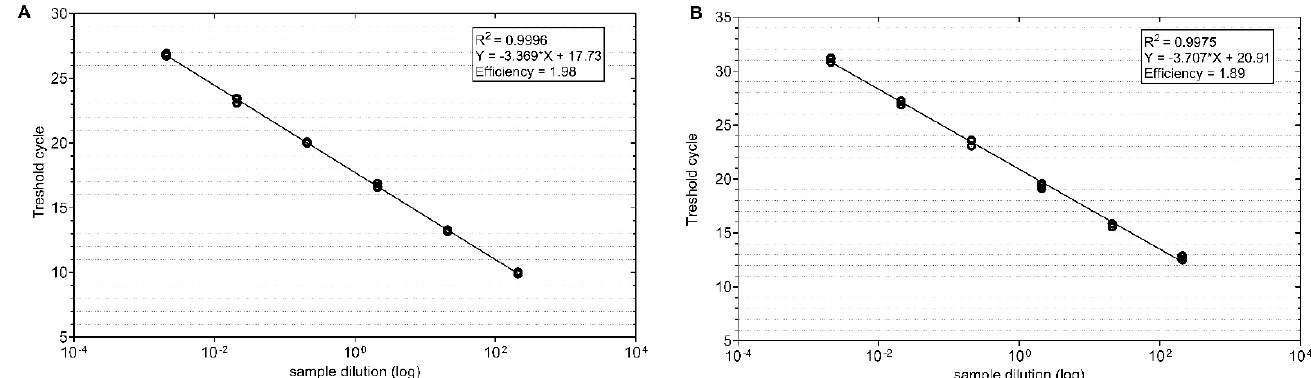
Figure 3. Standard curves for SYBR Green-I-based real-time RT-PCR amplification of standard TuYV DNA with specific primer sets ( A ) TuYV K1 and ( B ) TuYV K2. The amplification plots show the testing, in triplicate, of a ten-fold dilution series containing standard TuYV DNA from 2.1 × 10 2 to 2.1 × 10 4 template copies/reaction.